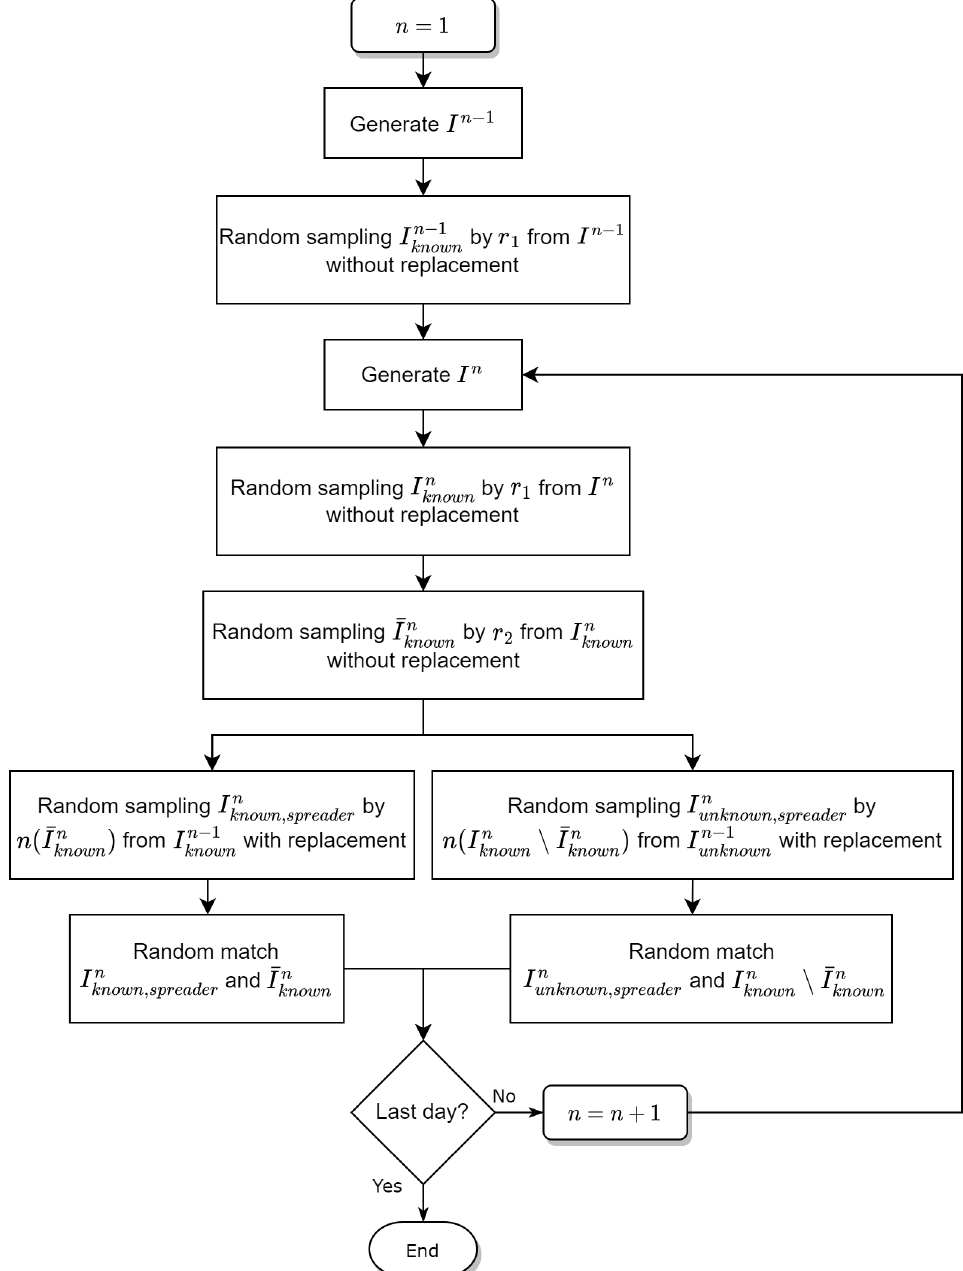
Figure 2. Diagram of the algorithm that generates the infected network. Figure 3 shows the infection network generated using the proposed algorithm when the observation period was 7 days and there were 10 confirmed cases every day. The number of chains is 7, which was expressed in seven colors in Figure